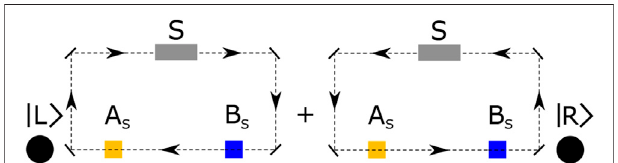
FIGURE3| Gravitationalquantumswitch .Thesysteminvolvesaphoton source S , two observers, A S and B S , and a BH in a state of superposition of being at two different positions relative to them, | L 〉 or | R 〉 . The direction in which the photon is emitted depends on the position of the BH and therefore theBH plays therole ofaquantum control forthe whole process. As aresult,thephotonisinasuperpositionoftravelingintwooppositedirections.